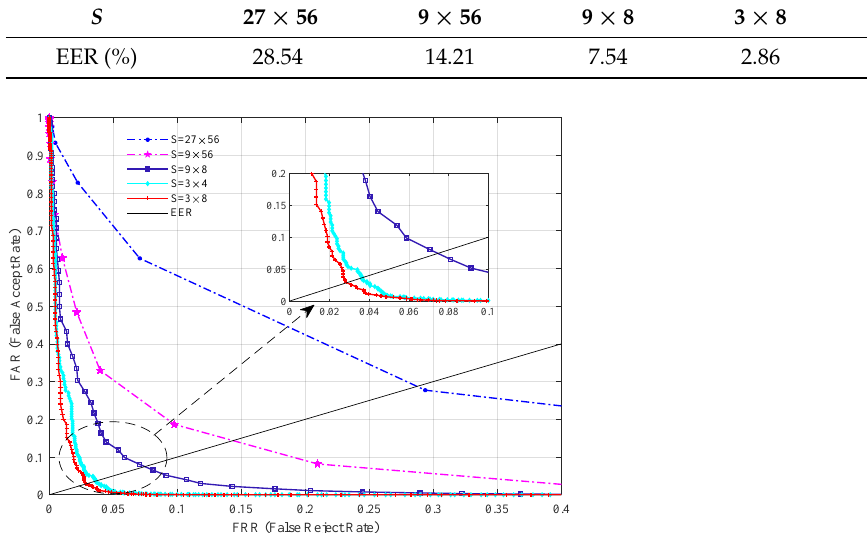
Table 4. The recognition performance under different block size.